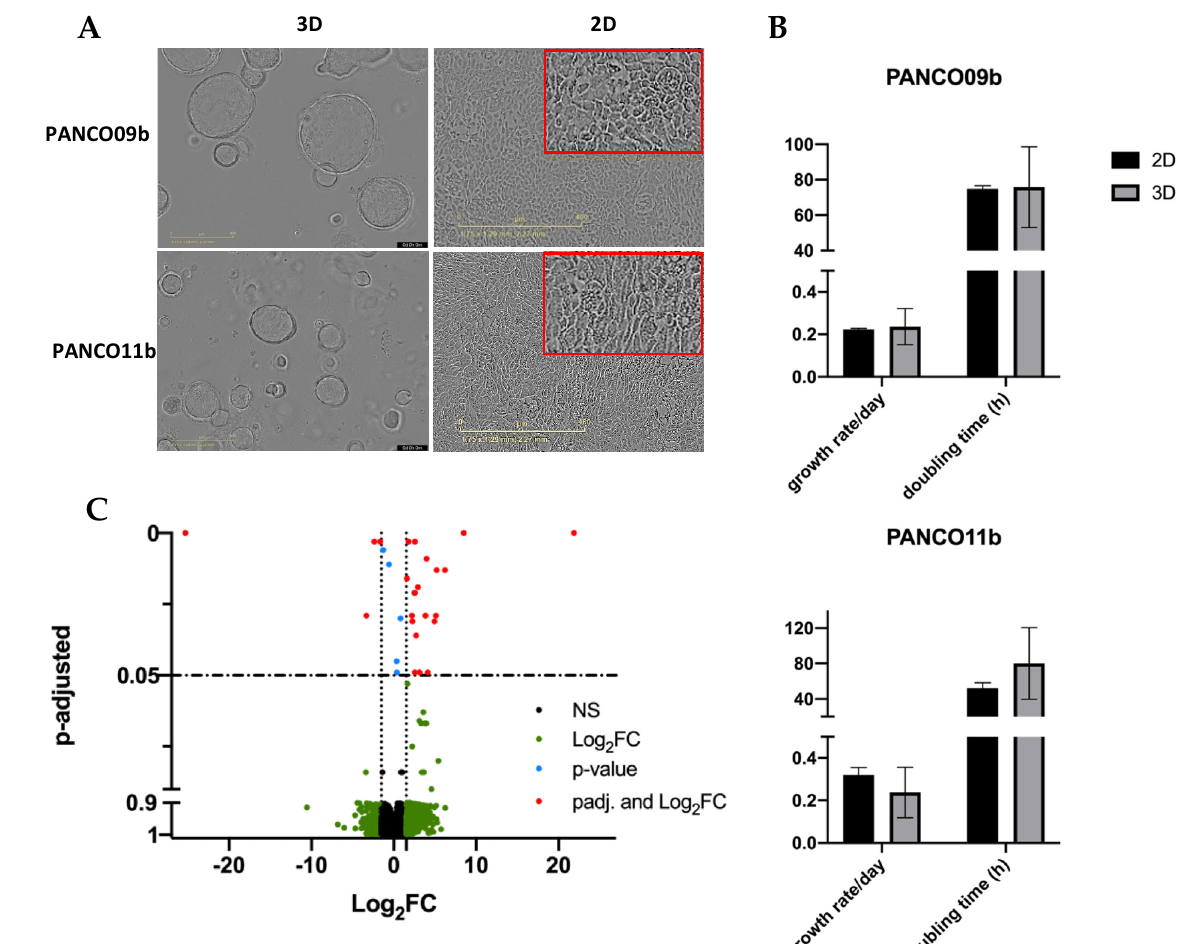
Figure 1. Basic characteristics of 3D and 2D cultured PANCO09b and PANCO11b cells grown in adv.DMEM/F-12. ( A ): Morphology of PANCO09b and PANCO11b grown in 3D or 2D. 4 × magnification (3D) and 10 × magnification (2D). ( B ): Doubling time in hours and growth rate/day of PANCO11b grown in 3D or 2D. Data are presented as mean ± SD. ( C ): Volcano plot representation of differential gene expression analysis between 3D organoids and corresponding 2D cultured cells. Red dots show significantly differentially expressed genes in 3D compared to 2D.